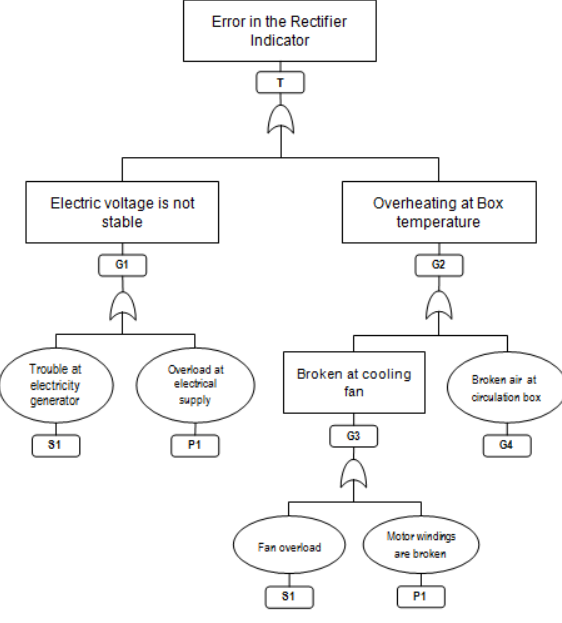
Figure 5. Influence of the auxiliary parameter on the local velocity distribution with the property = 0.2 The minimum cut set from the structural image above is P1, P2, P3,